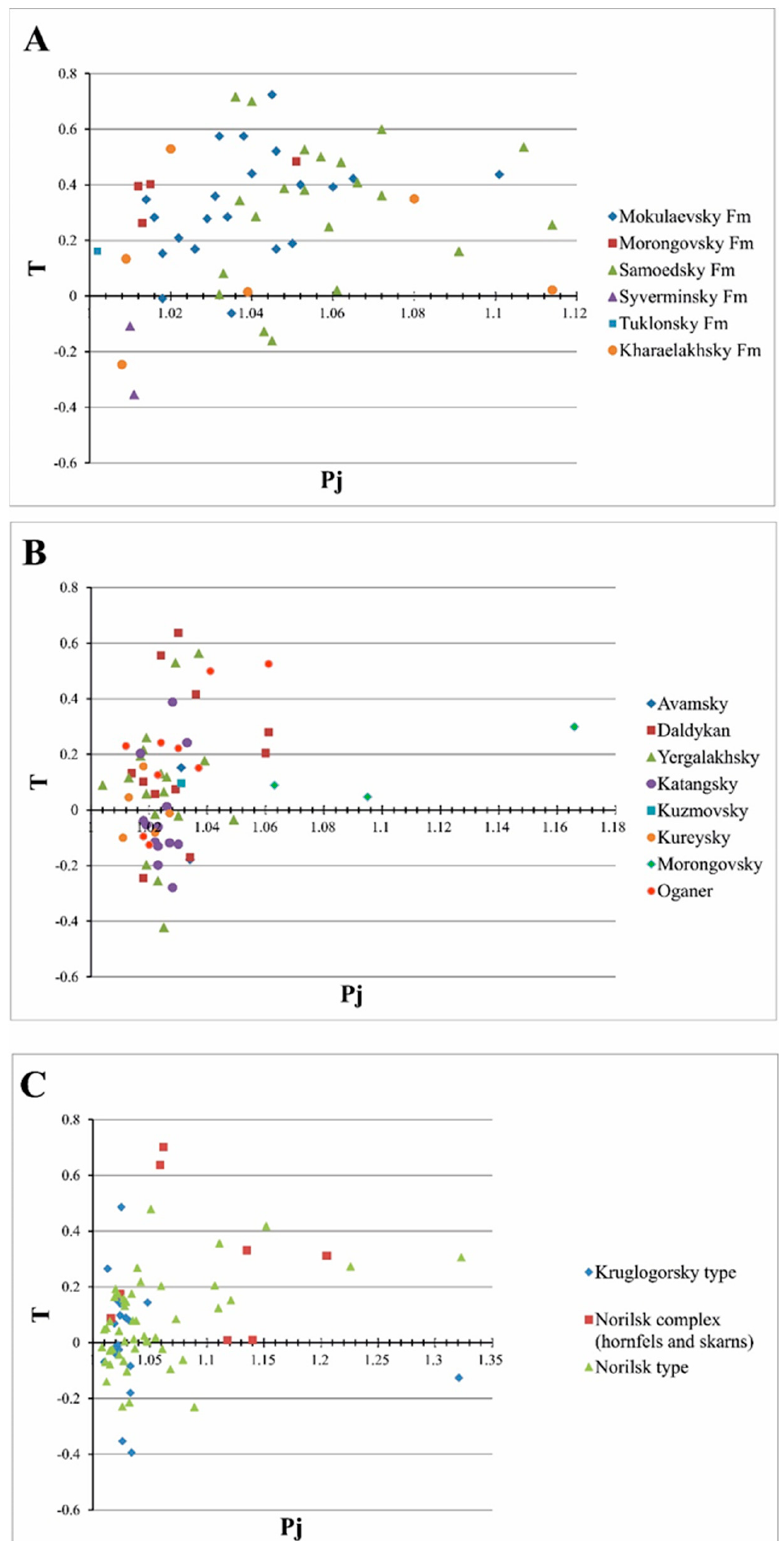
Figure 3. Jelinek plots for the studied intrusions and lava flows. Pj and T − site-mean values for the corrected degree of anisotropy and shape parameter, respectively. ( A ) volcanic formations; ( B ) intrusive complexes; ( C ) ore-bearing intrusions of the Noril’sk complex and their contact zones.